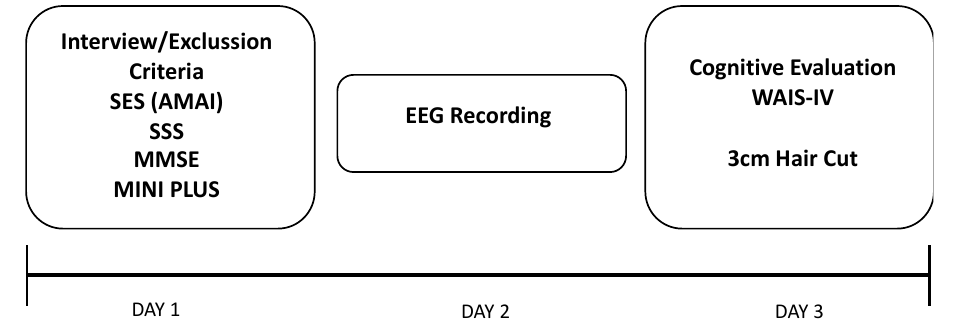
Figure 1. Schematic representation of the experimental procedure. SES: socioeconomic status; AMAI: questionnaire of the Mexican Association of Marketing Research and Public Opinion Agencies; SSS: subjective socioeconomic status; MMSE: Minimental State Examination; MINI PLUS: Mini International Neuropsychiatric; WAIS-IV: 4th version of the Wechsler Adult Intelligence Scale.